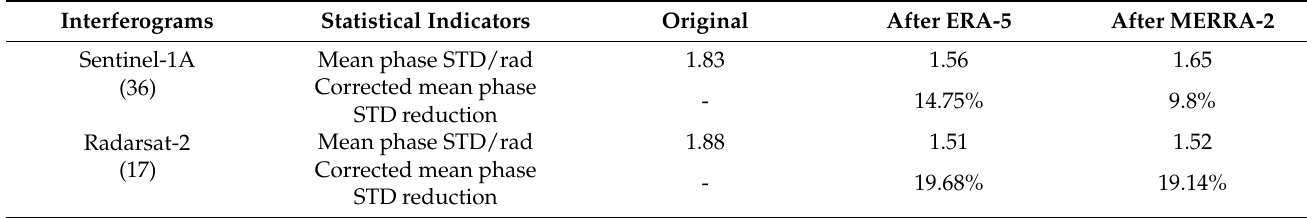
Figure 6. Radarsat-2 and Sentinel-1A interferograms before and after total atmospheric delay correction. ( a ) Sentinel-1A. ( b ) Radarsat-2. Table 4. Statistical results for different atmospheric delay correction